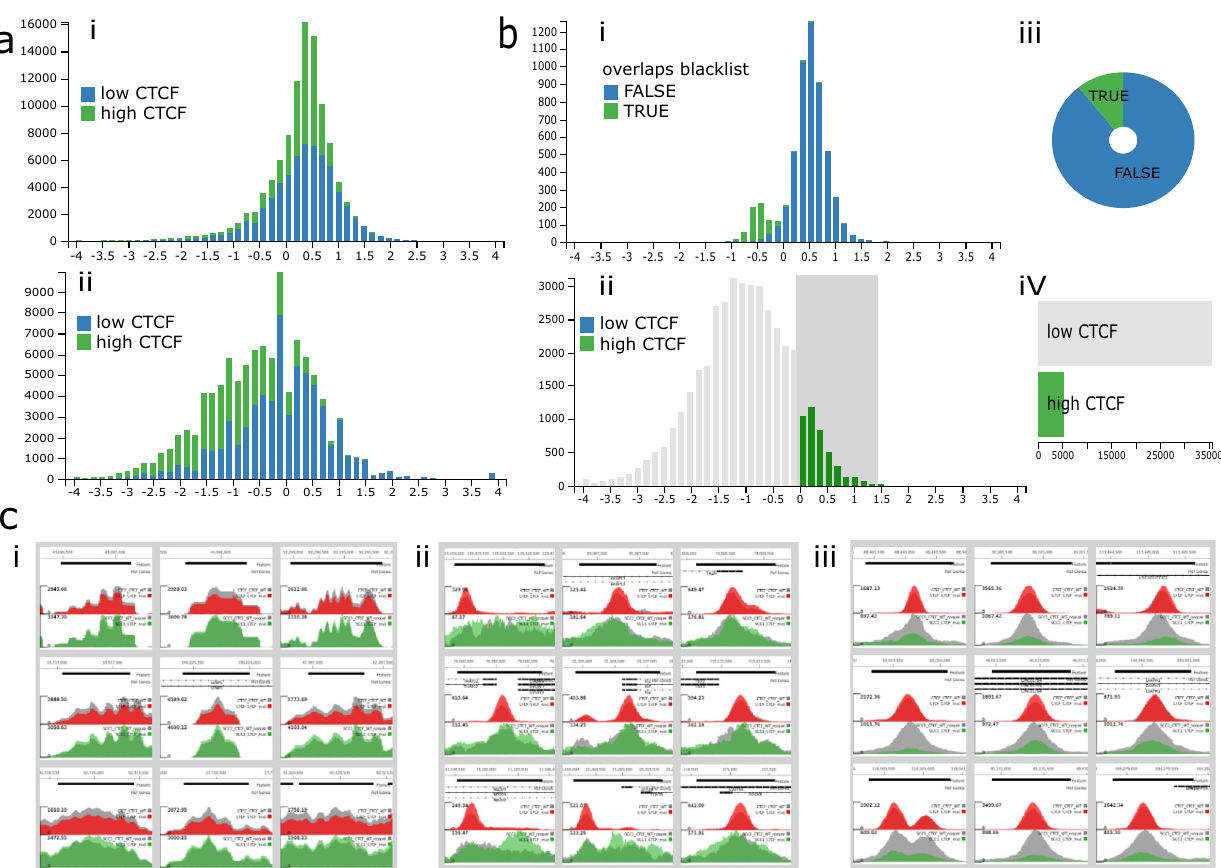
Fig. 3 Analysis of SCC1 and CTCF ChIP-seq data. https://mlv.molbiol.ox.ac.uk/projects/multi_locus_view/2057 Data taken from from the The Structural Basis for Cohesin-CTCF-anchored Loops 11 . a Histograms of CTCF ( i ) and cohesin ( ii ) log2 fold changes. The bars are coloured by tags (green - high CTCF, blue - low CTCF). b Filtering of strong CTCF binding sites with no decrease in SCC1 binding in the CTCF mutant. ( i ) Histogram showing the bimodal distribution of the CTCF log2 fold changes between the mutant and the WT in the selected regions. The green bars show black listed regions. ( ii ) Histogram of cohesin log2 fold change between the mutant and WT, the grey box shows the regions (those with a log2 fold change greater than 0) that were selected. ( iii ) Pie chart showing the proportion of black listed regions (green) in the selected regions. ( iv ) Row chart showing tags, which was used to select regions with strong CTCF binding (high CTCF). c Representative samples of genome browser images. The upper track shows CTCF ChIP-seq peaks with the grey track being WT and the red track, the CTCF mutant. The lower track shows SCC1 (cohesin) data with the WT grey and the CTCF mutant and green ( i ) the small left-hand peak in b ( i ) consisting of black listed regions, ( ii ) regions with strong CTCF binding, but no reduction of cohesin binding in the CTCF mutant (the large right-hand peak in b ( ii )), ( iii ) typical peaks for the majority of regions with strong CTCF